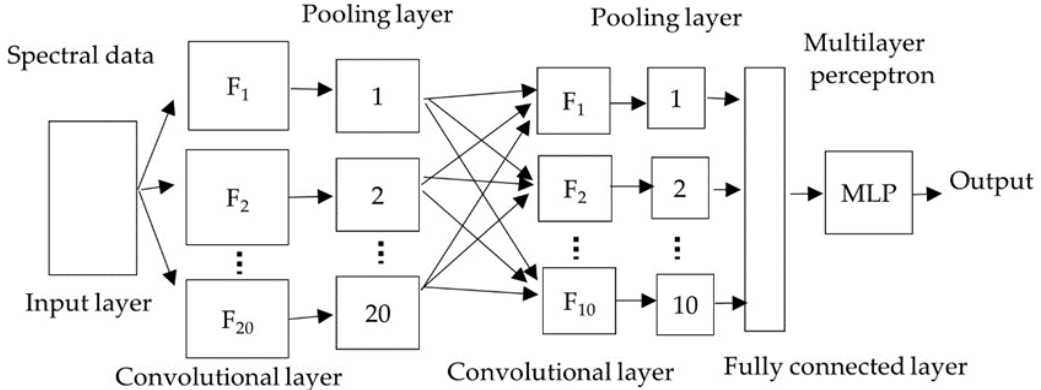
Figure 3. The structure of the Convolutional Neural Network (CNN) prediction model.